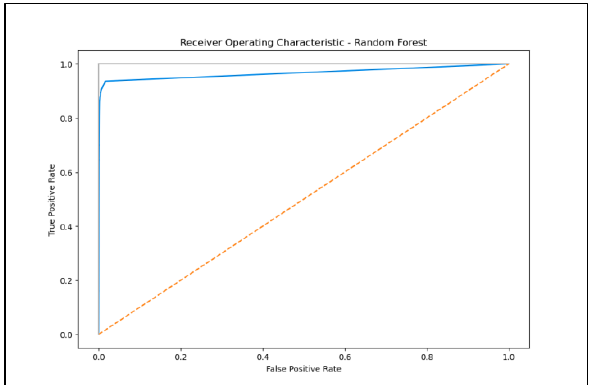
Figure 18: Features importance through the machine learning modelling.